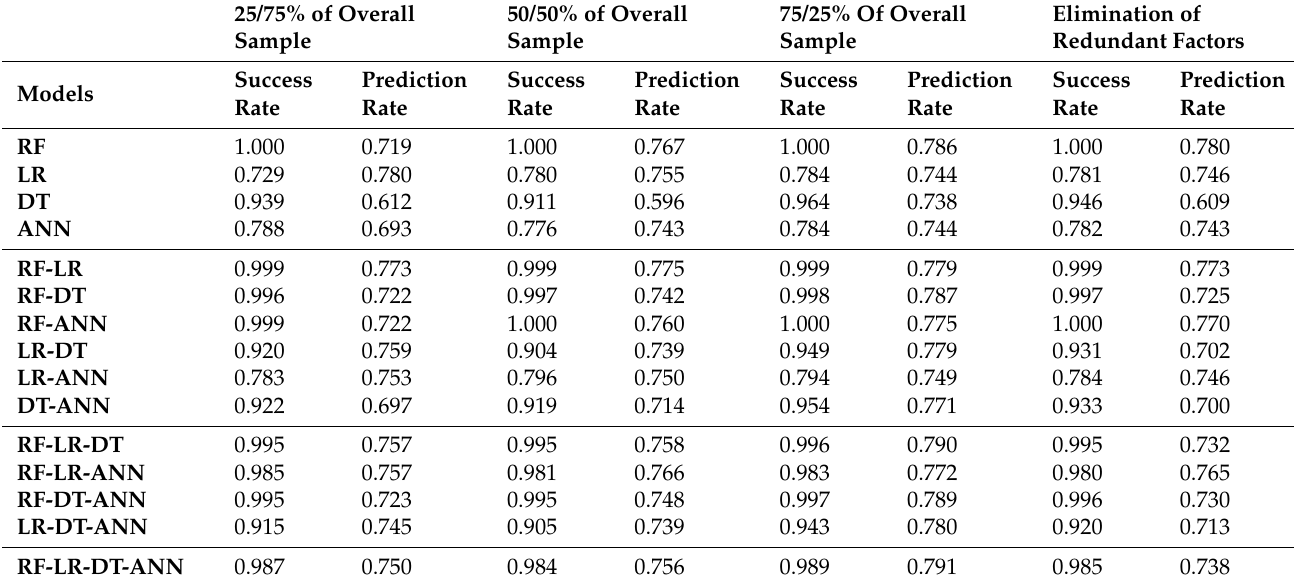
Table 4. Gain in success and prediction rate using the partition Training/Testing progresses from 25/75% to 75/25% with redundant factors